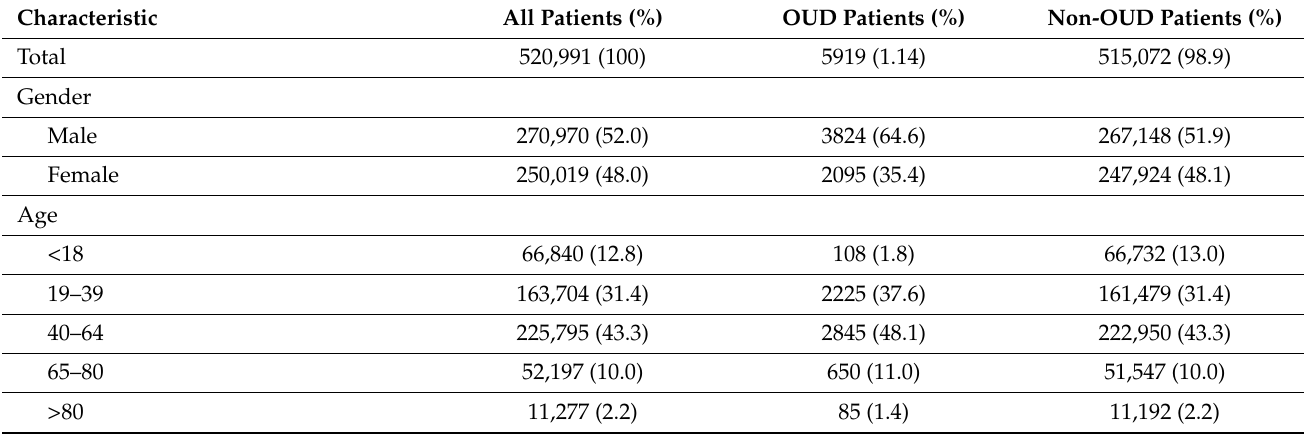
Table A4. Demographic and Clinical Characteristics of Los Angeles County ED